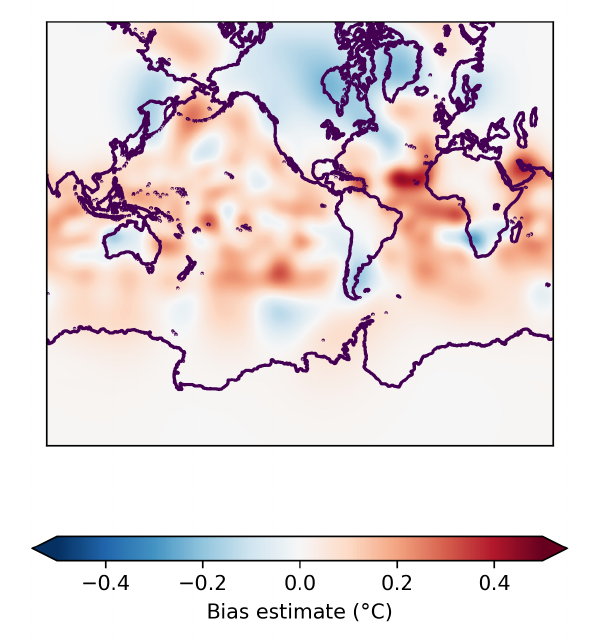
Figure 7. Bias field for the Sentinel 3A SLSTR data for 1 October 2019. Land boundaries are shown, but the analysis is generated without a land-sea mask and so the bias estimates extend over the